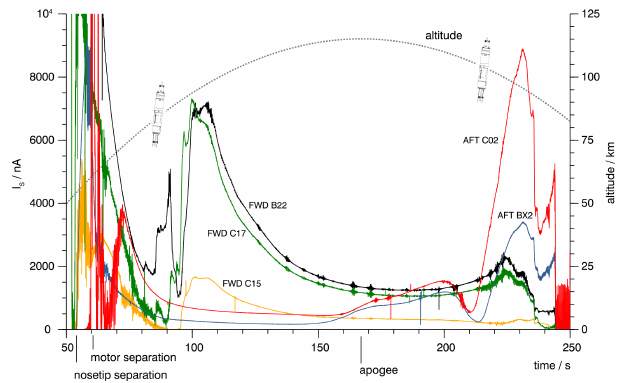
Figure 8. Raw signals of the atomic oxygen sensors vs. flight time, together with the altitude and rocket orientation during the experi- mentation phase.